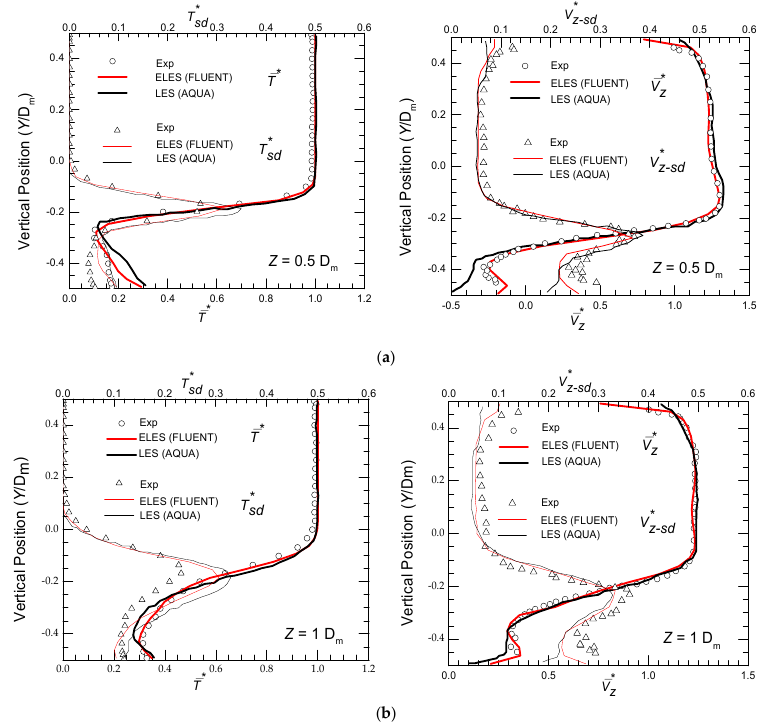
Figure 9. Temperature and velocity distributions along vertical lines in the W-ref case: ( a ) Line − I, = 0.5 D m ; ( b ) Line − II, Z = 1 D m The calculated distributions were in good agreement with those in the